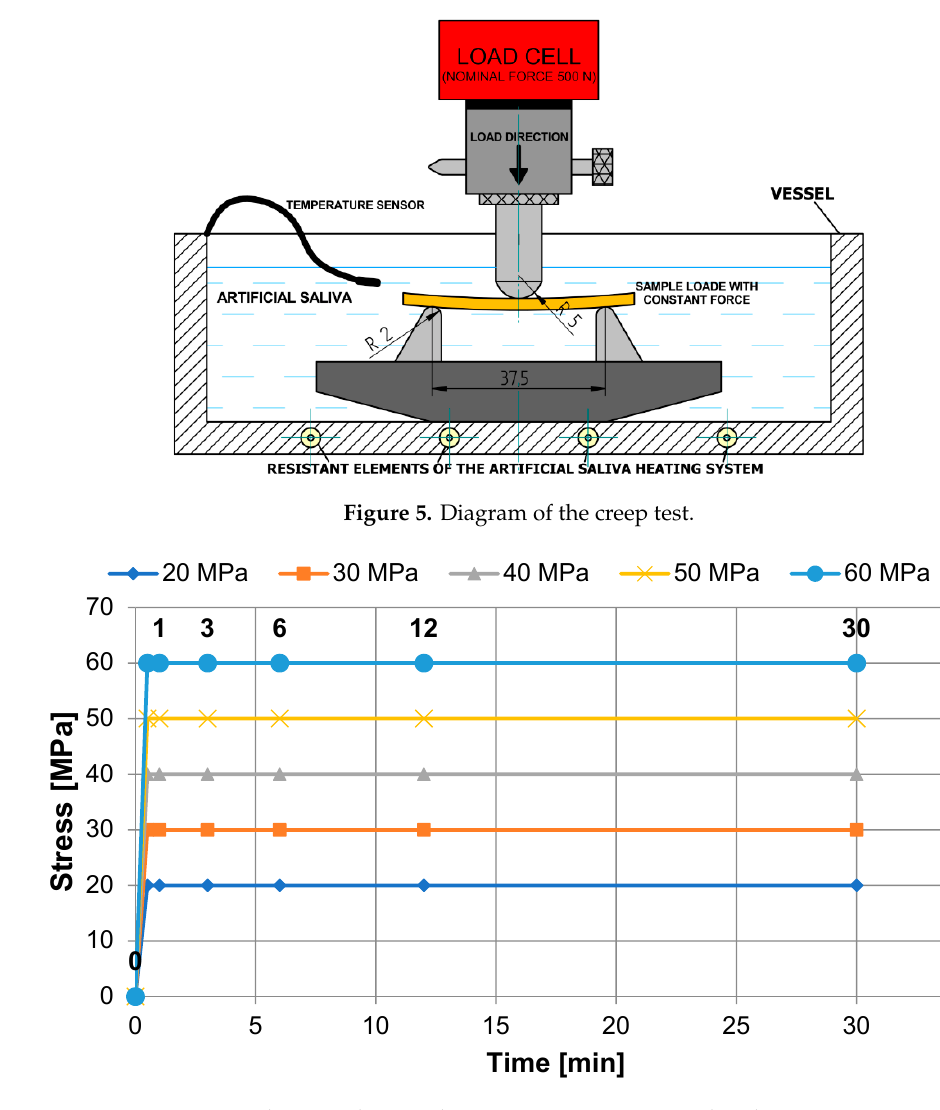
Figure 6. Theoretical stress characteristics-time assumed in the creep test.